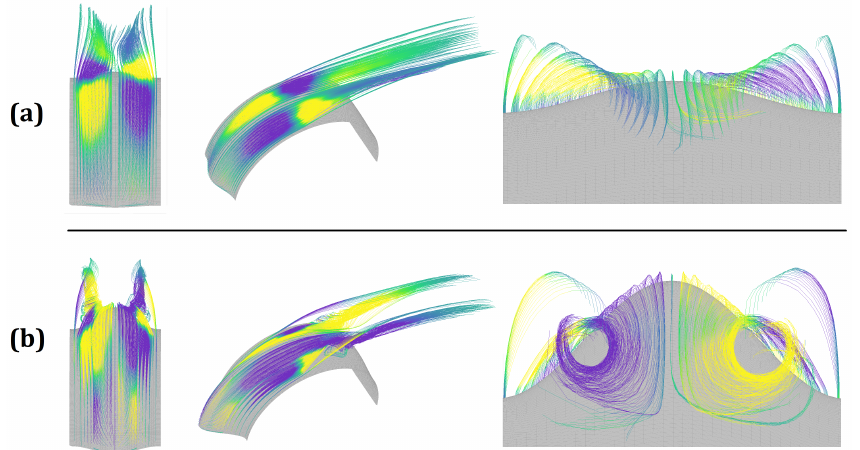
Figure 18. Mean flow-based streamlines showing the formation of coherent streamwise vortices for the wavy cylinders: A03 ( a ) and A11 ( b ). Only case A11 produces effectively complete cyclical vortices. The colors indicate local streamwise